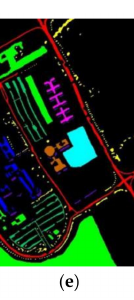
Figure 10. Pavia University hyperspectral image classification result image. ( a ) Training Dataset 1, ( b ) training Dataset 2, ( c ) training Dataset 3, ( d ) training Dataset 4, ( e ) ground truth.